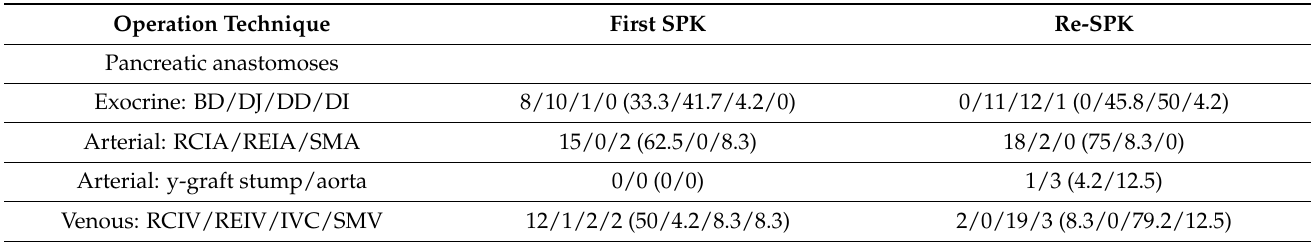
Table 4. Operation